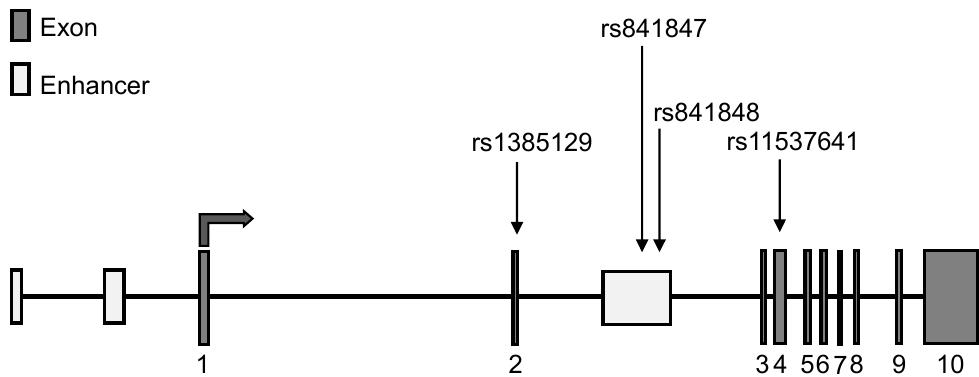
Figure 1. Structure of human SLC2A1 gene with the 10 exons (indicated as 1–10) and the putative enhancers [5]. The 4 examined SNPs are also presented.